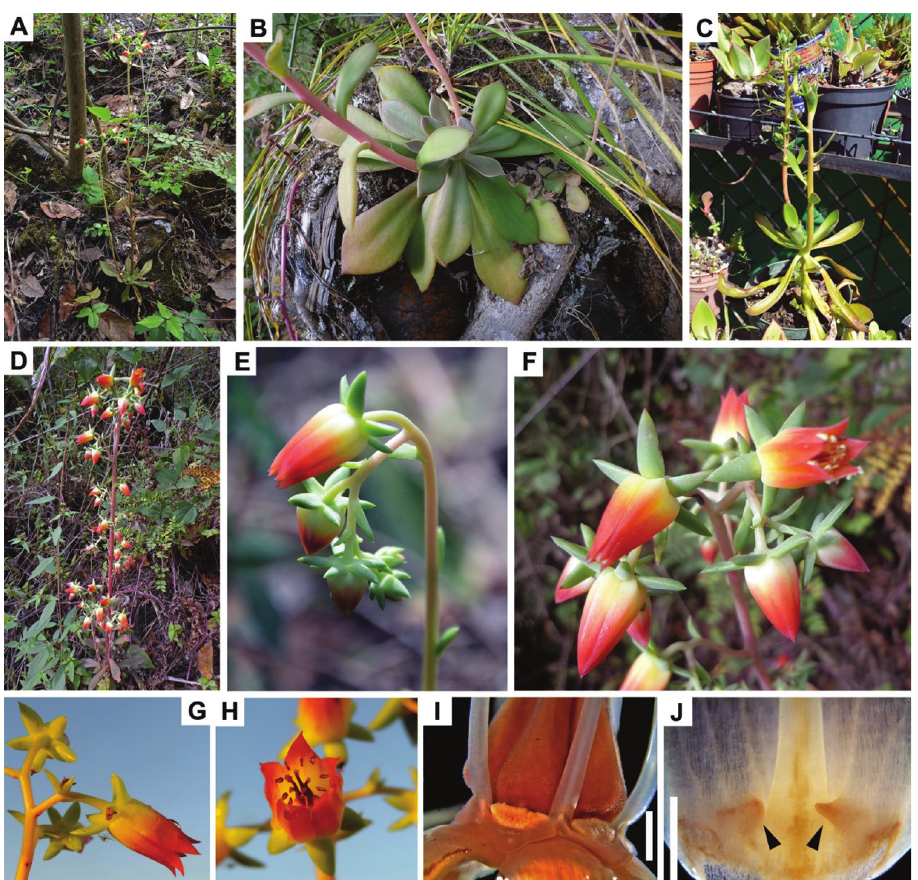
Figure 1. Habitat and general morphology of Echeveria coruana . A Habitat B Leaf rosette of type specimen C Developing plant (in cultivation) D–F Inflorescence D General view E Developing cincinus F Terminal cincinni G–H Flowers of type specimen viewed in the field from different angles I–J Flowers from type specimen fixed in FAA I Dissected flower (removed corolla) to show stamen bases and nectaries. J Conical appendages at the base of antipetalous staminal filaments (indicated with black arrows). Scale bars 1